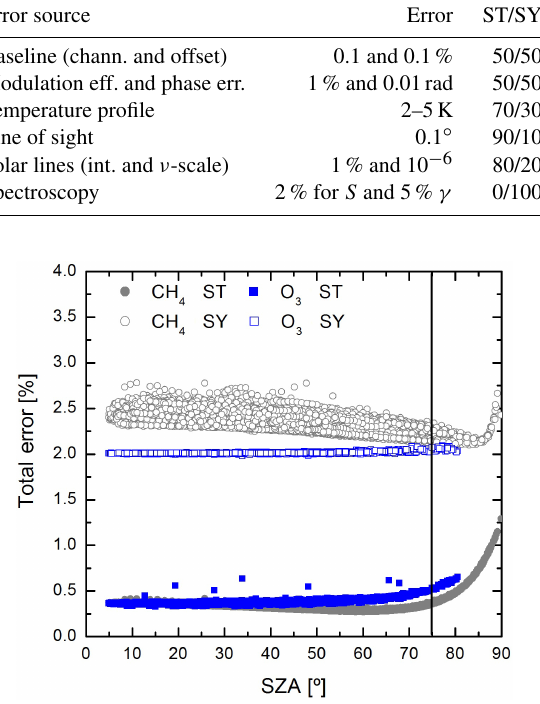
Figure A1. Total statistical (ST) and systematic (SY) errors (in %) as a function of the solar zenith angle (SZA, in ◦ ) for FTS O 3 and CH 4 measurements between 2010 and 2014. The black solid line represents the limit value of SZA = 75 ◦ . Beyond this value the FTS observations are